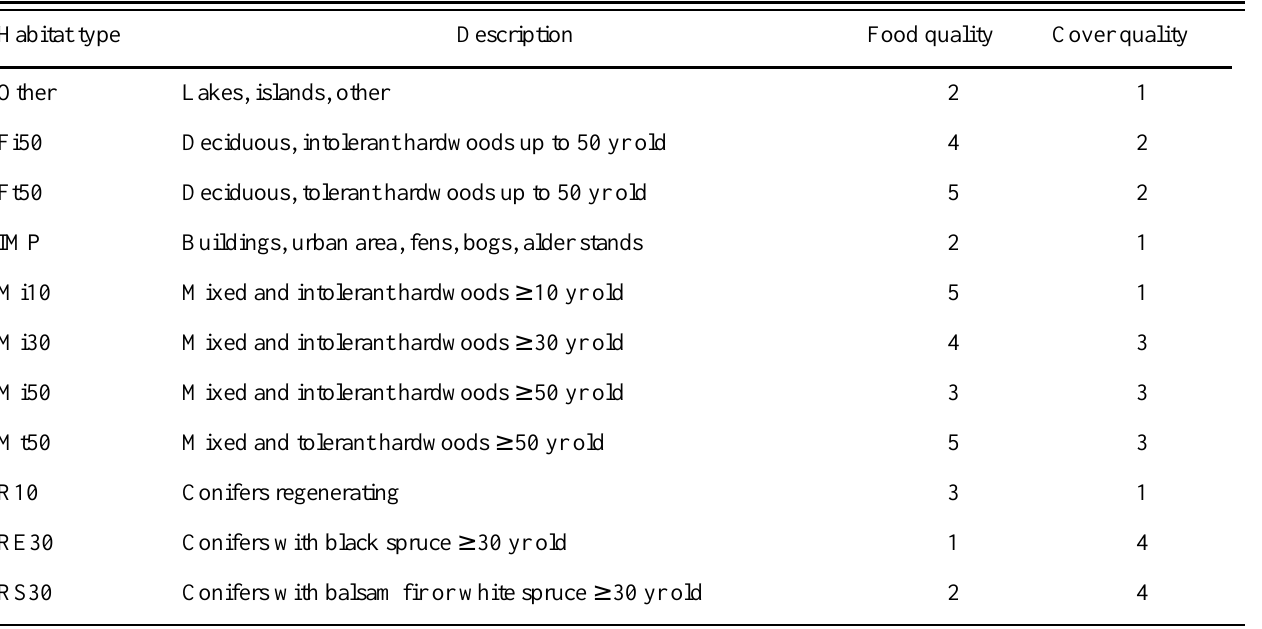
Table 1 . Description of habitat types used to model moose behavior along highways in the Laurentides Wildlife Reserve, Quebec, Canada. Habitat types were based on the vegetation available in each forest polygon found on forest maps of the study area. Each habitat type was also assigned a value for its food and cover quality attributes as suggested by Dussault et al. (2006 b